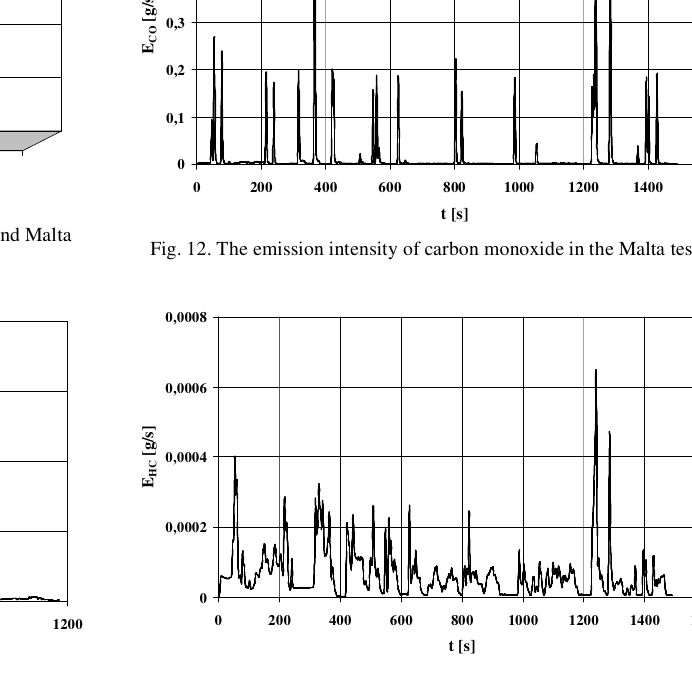
Fig. 13. The emission intensity of hydrocarbons in the Malta test